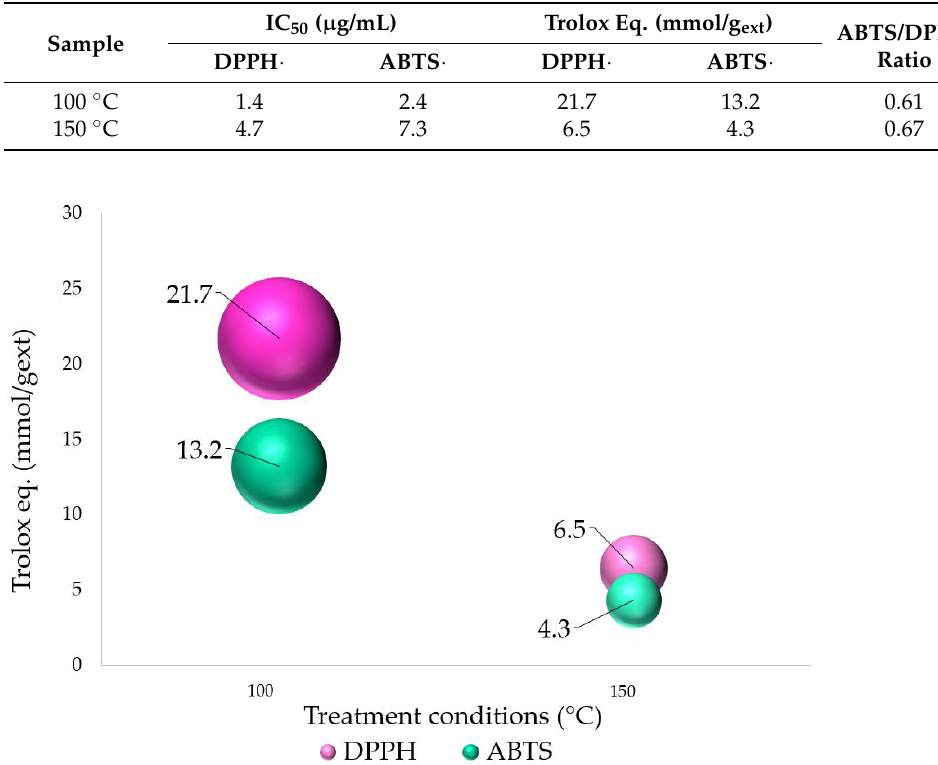
Figure 3. Evaluation of the antioxidant activity, with DPPH · and ABTS · assays, expressed as Trolox equivalents.